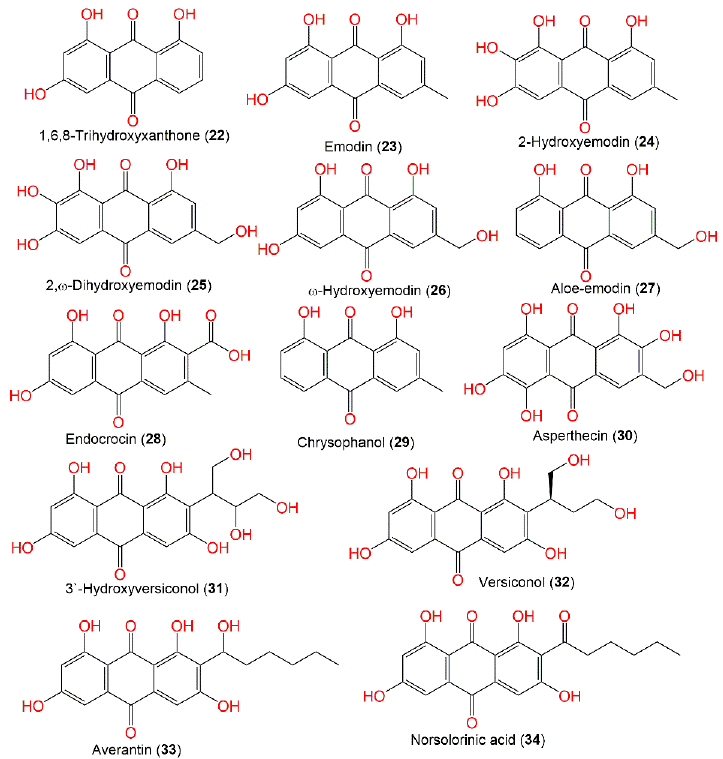
Figure 3. Structures of quinones ( 22 – 34